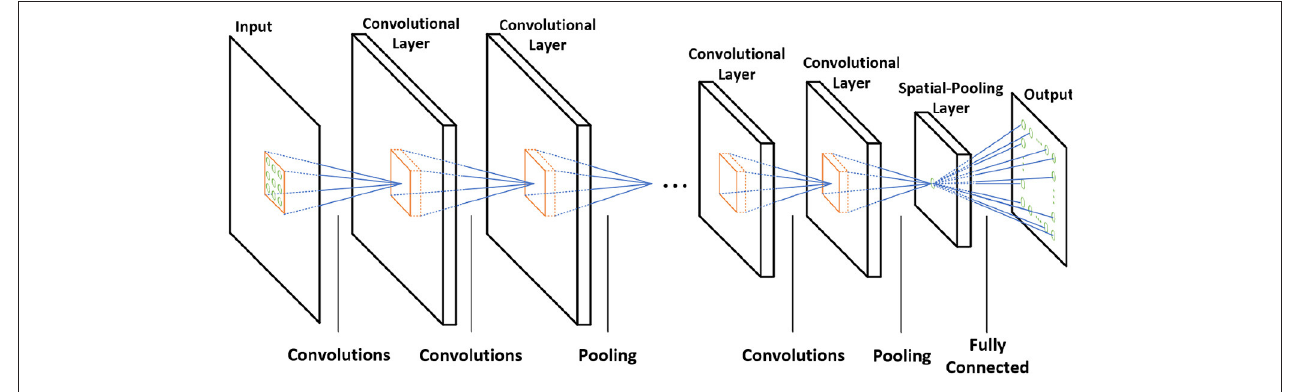
FIGURE 2 | The architecture of the